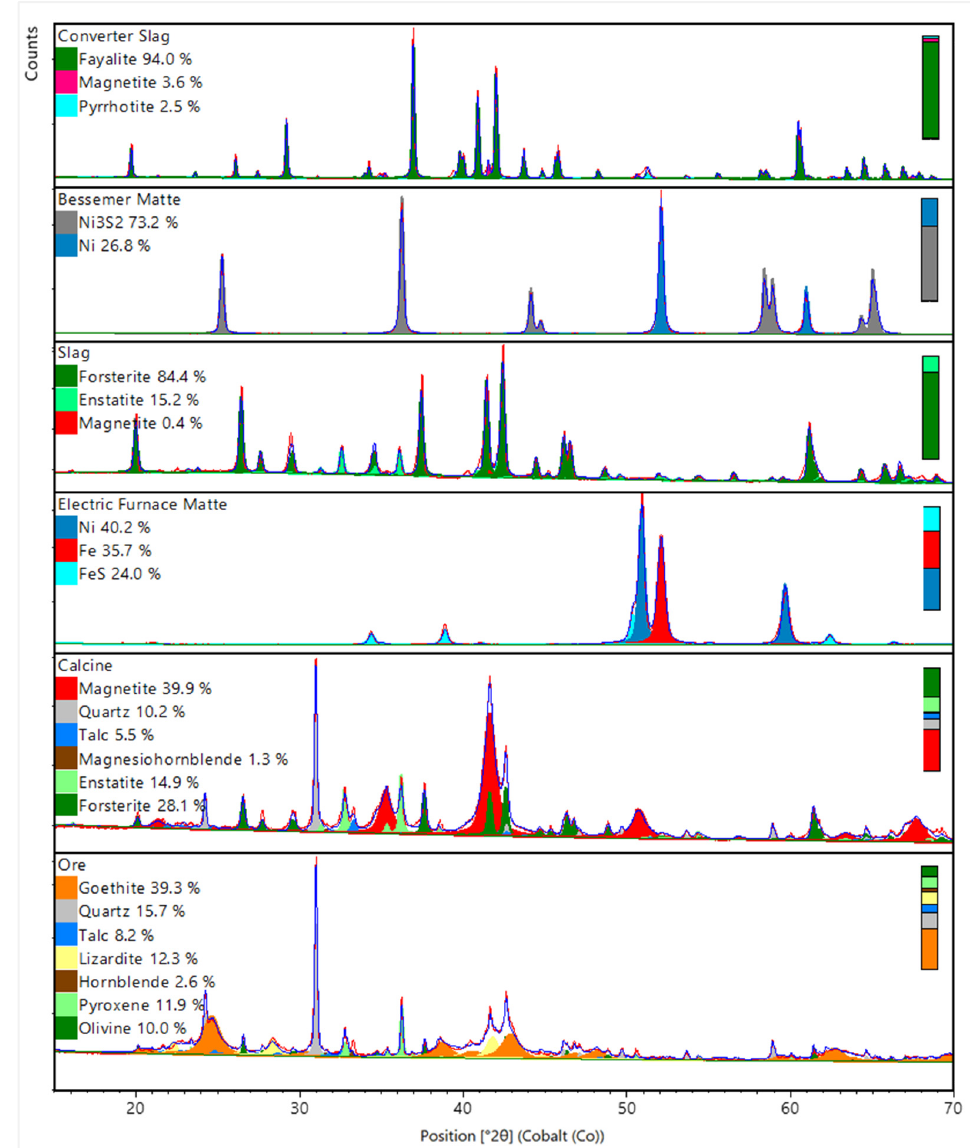
Figure 13. Example of a full-pattern Rietveld quantification for several processed materials of the pyrometallurgical extraction of nickel from laterites (Ore R wp = 4.6, Calcine R wp = 5.0, Electric Furnace